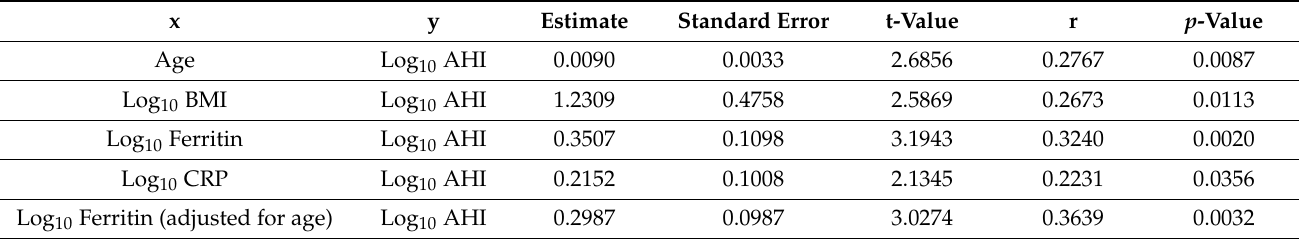
Table 4. Di ff erent correlations with the apnea–hypopnea index. Table 4. Different correlations with the apnea–hypopnea